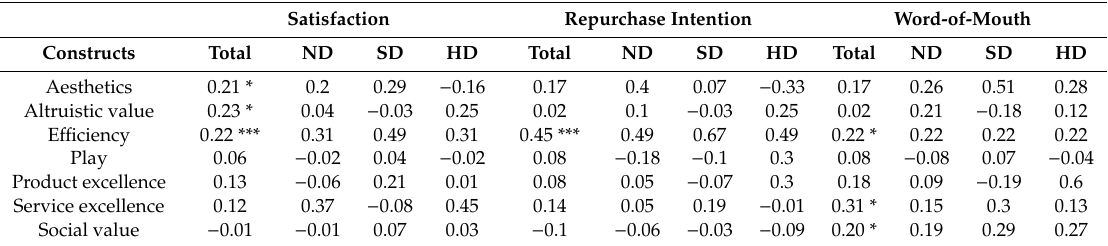
Table 10. Path coe ffi cient results in di ff erent retail